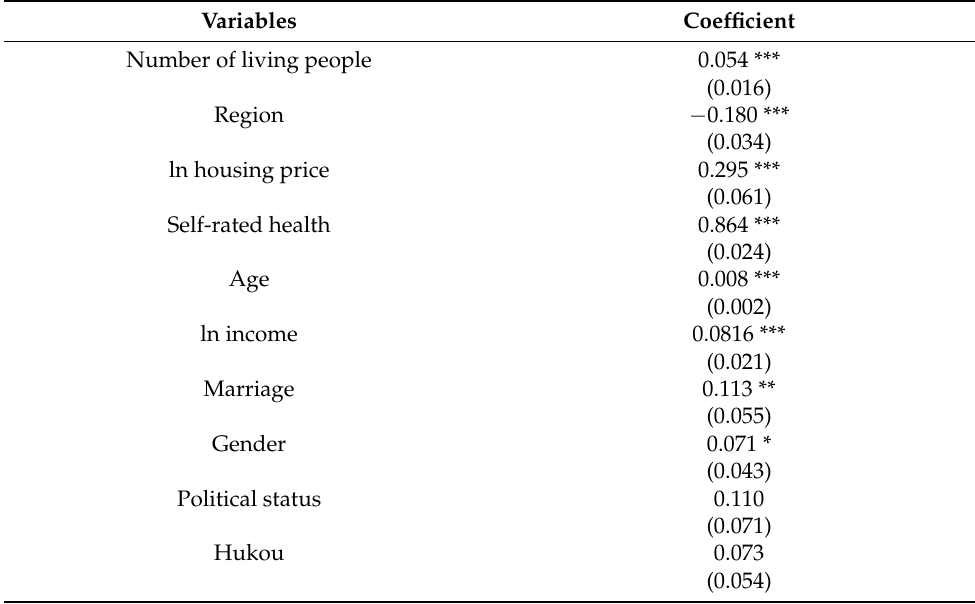
Table A2. Results for stepwise ordered logistic regression of mental